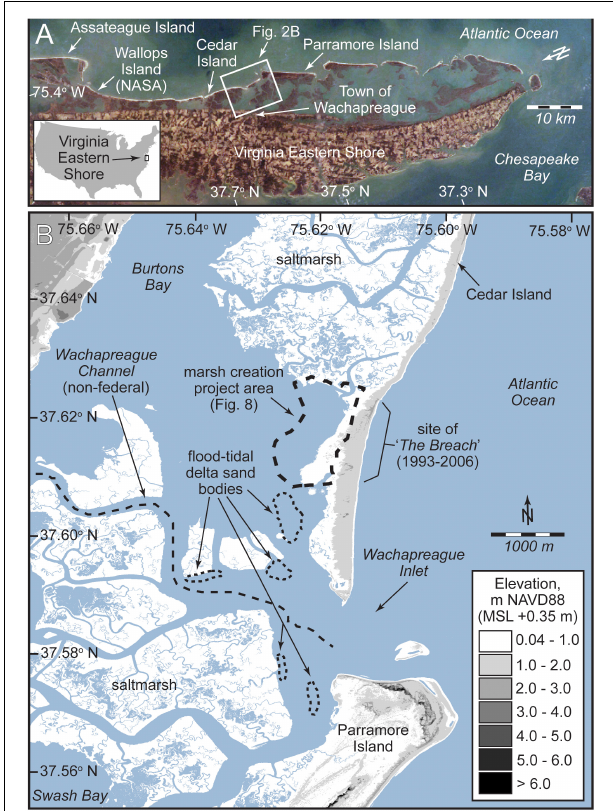
FIGURE 2 | Project study site. (A) The Virginia Eastern Shore and its barrier islands. Modified from Deaton et al. (2017). (B) Southern Cedar Island and vicinity, showing key features, channels, flood-tidal delta shoals, and the marsh creation project area. Digital elevation model is from topographic